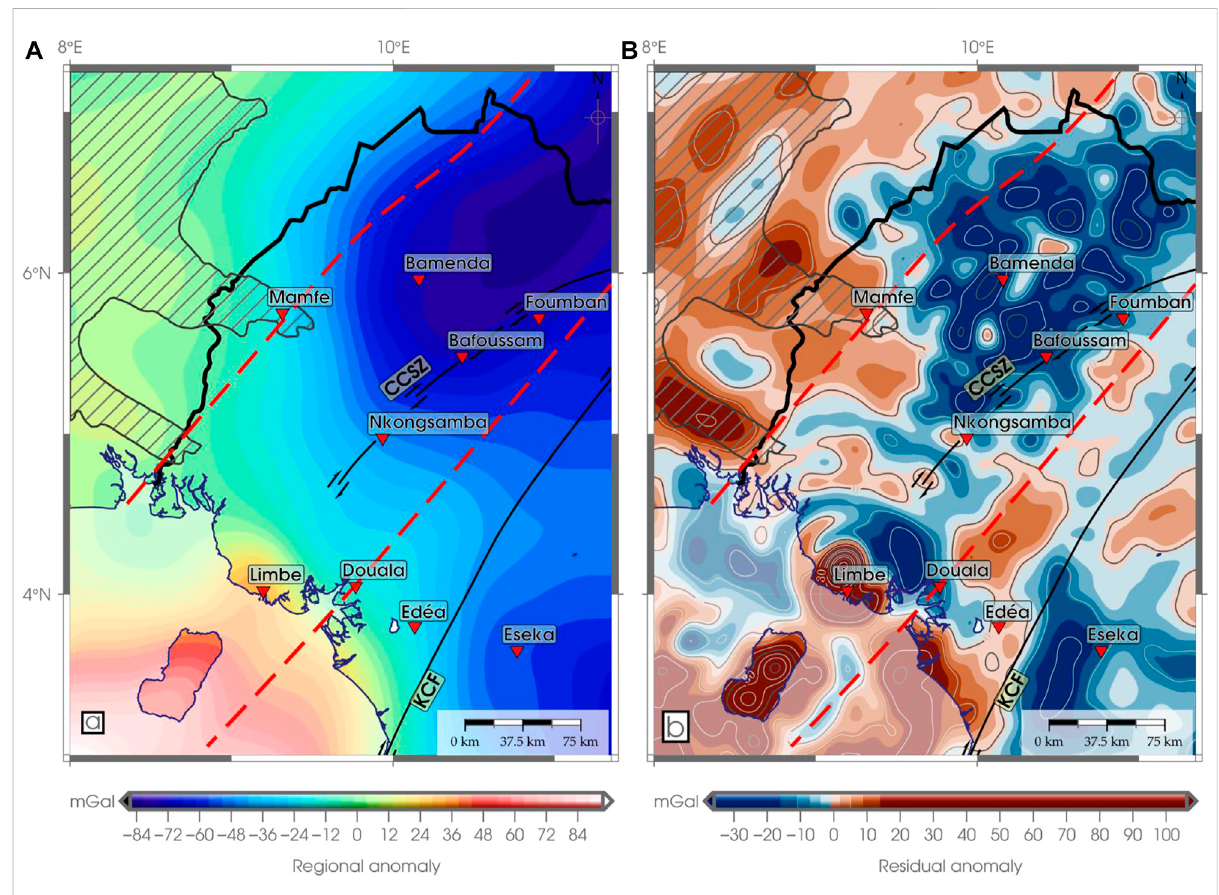
FIGURE 5 (A) Bouguer regional map; and (B) Bouguer residual map (black lines represent national